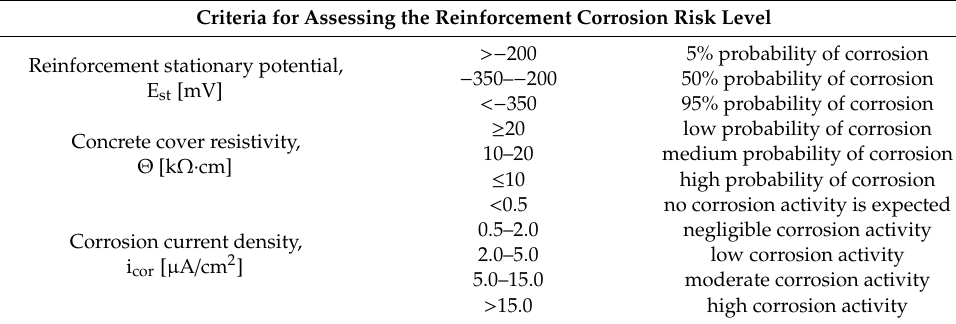
Figure 5. Diagram of connection of GP-5000 GalvaPulse TM with diagnosed reinforcement: ( a ) sketch [own study on the basis of Reference [43]]; ( b ) measurement on a specimen. Table 2. Criteria for assessing the reinforcement corrosion risk level [40,43].